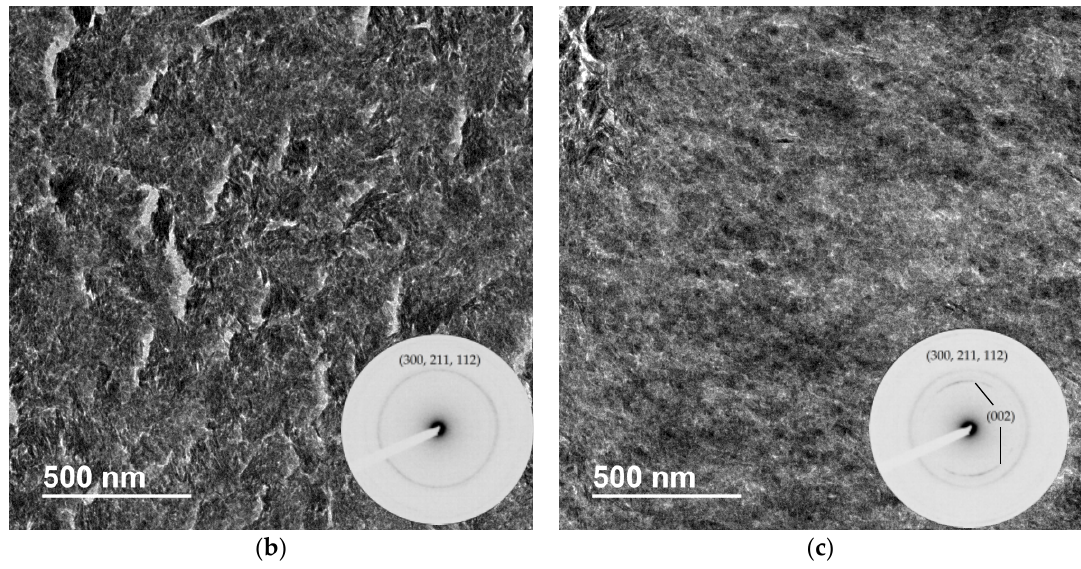
Figure 4. BF-TEM and corresponding selected area electron diffraction (SAED) patterns of PILP mineralized LCC (X32). ( a ) The herringbone pattern results when lamellae are sectioned on a bias; the shifting orientation of collagen fibrils is represented by the series of nested arcs (dashed white line) which create a herringbone pattern. Because the collagen fibrils serve as a template for mineralization, the crystallographic c -axes of PILP formed crystals should be oriented along the axis of the collagen fibrils such that SAED can assist in interpreting the image. The regions marked ‘b’ and ‘c’ are shown at a higher magnification with corresponding diffraction patterns in Figure 4b,c, respectively; ( b ) The absence of the (002) reflection in the diffraction pattern (inset) indicates that the zone axis is very close to [001], therefore the fibril axes are oriented perpendicular to the image plane; and, ( c ) The presence of (002) arcs in this diffraction pattern (inset) indicate that the crystallographic c -axes are co-oriented with collagen fibril axes and are parallel to the image plane.